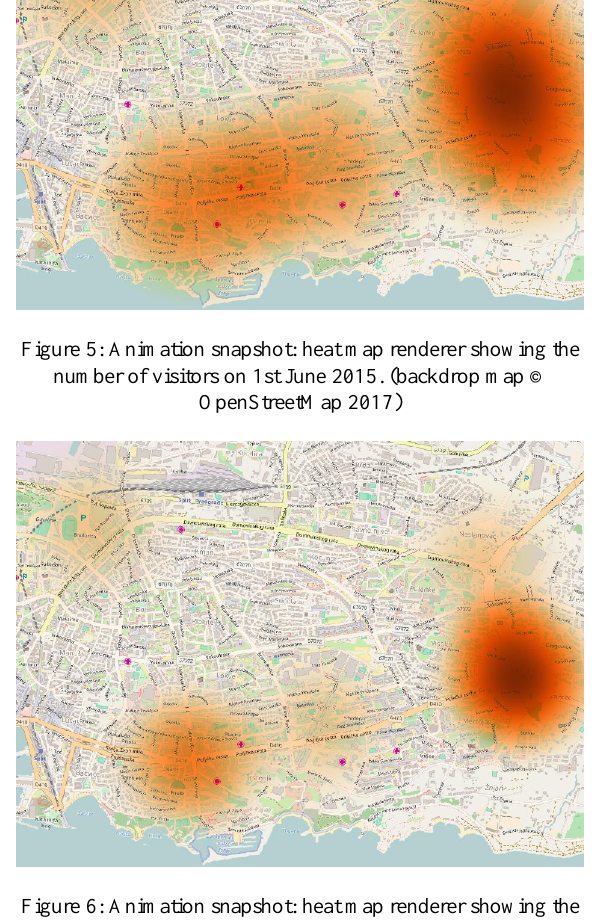
Figure 6: Animation snapshot: heat map renderer showing the number of visitors on 20th July 2015. (backdrop map © OpenStreetMap